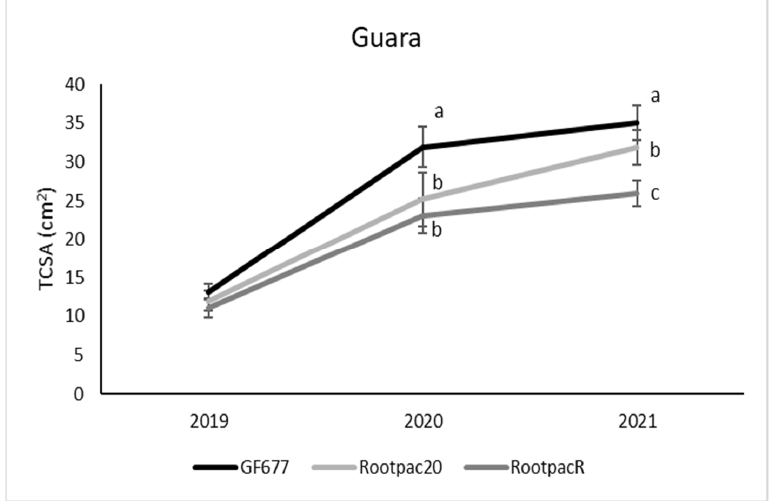
Figure 4. Comparison of annual mean values of trunk cross-sectional area (TCSA) computed at 30 cm above the ground, and recorded at the end of growing season over the period 2019–2021 for cultivars ‘Guara’ grafted on clonal rootstocks ‘GF677’, ‘Rootpac ® 20’ and ‘Rootpac ® ’ (trial B). Lowercase letters on the graph mean values indicate significant differences between rootstock per year (Fisher’s test p <